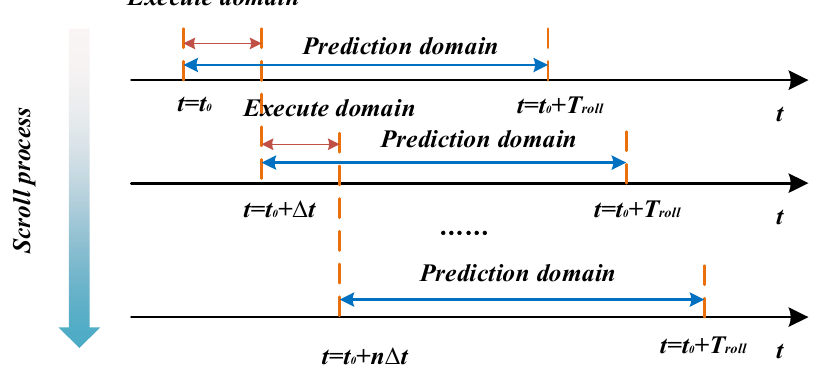
Figure 2. Rolling optimization process.